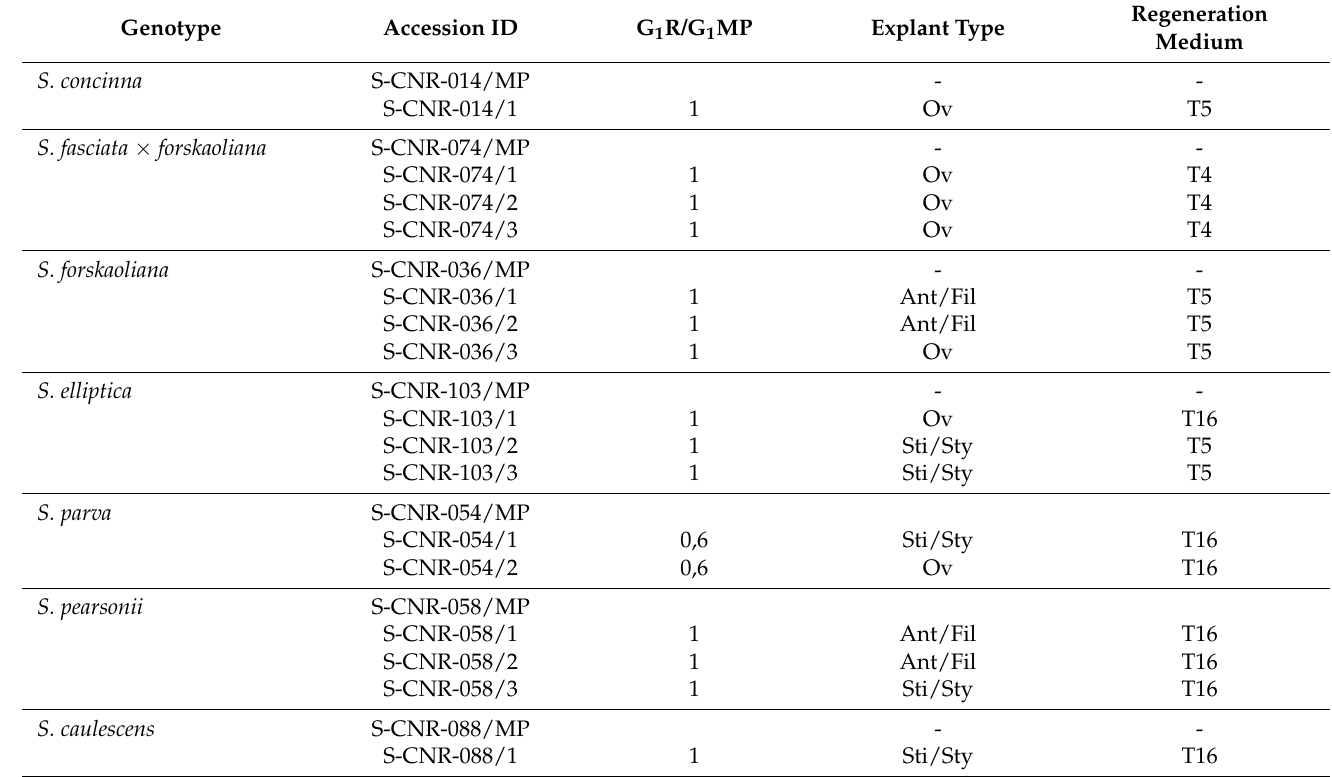
Table 1. The table summarizes the relationship between Sansevieria ’s genotypes used, the number of the accession, the ratio between the G1 peak of regenerants (R) and corresponding mother plant (MP), the type of explant and the regeneration medium